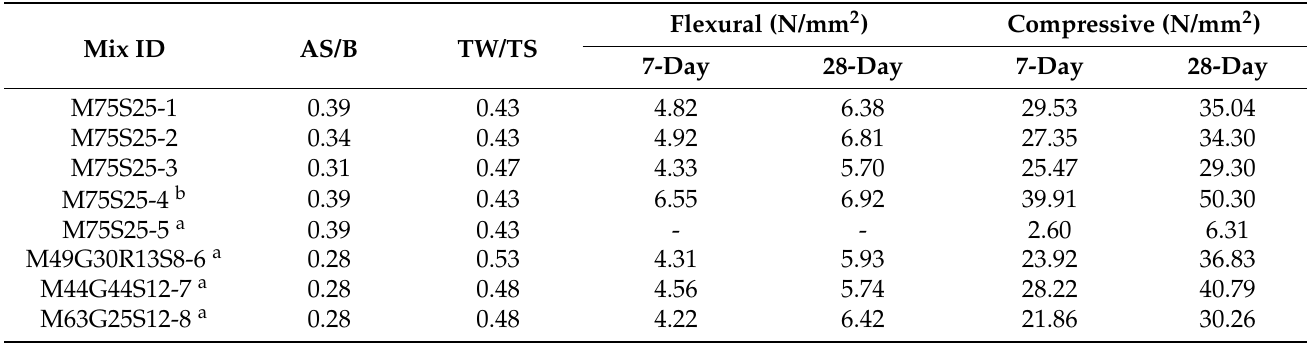
Table 4. Details of mix proportions and results for MK-based concretes.